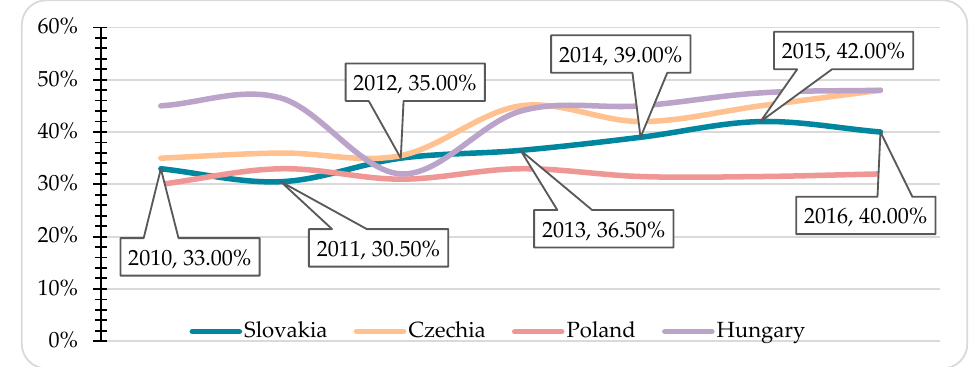
Figure 3. Gross value-added per employee under V4 2010–2017. Source: Authors’ compilation. The export of Slovakia in 2019 once again confirms the dependence on the automotive industry (33.4%—currently increased by 0.6%) and also explains the lower added value, see Table 4, as only completed cars were exported from Slovakia [41]. The second most dominant industries were electrical machinery and equipment (17.10%), followed by other machinery and equipment (12.30%), and iron, steel, and other metals (9.95%). Plastic and rubber were exported from Slovakia in 2019 at 5.45% of the exports. Table 4. Exports from Slovakia in 2019. Exports from Slovakia in 2019 (90.3 bl. eur) Vehicles and their parts